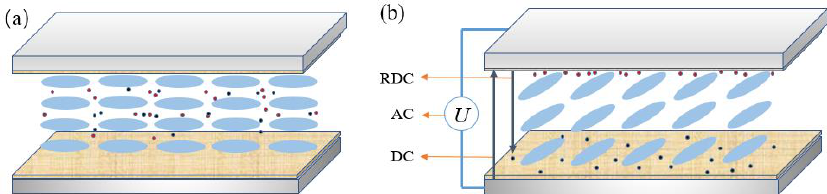
Figure 3. ( a ) Natural state of liquid crystal (LC) molecules and ionic impurities in the PAN cell. ( b ) Distribution of LC molecules and ionic impurities under applied voltage in the PAN cell.